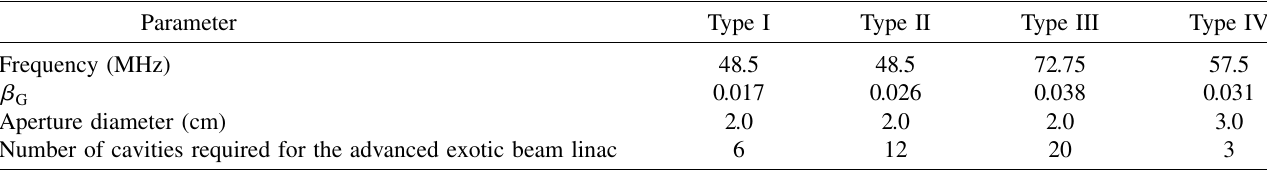
TABLE I. Basic parameters of 4-gap QW resonators for the EBF at ANL.